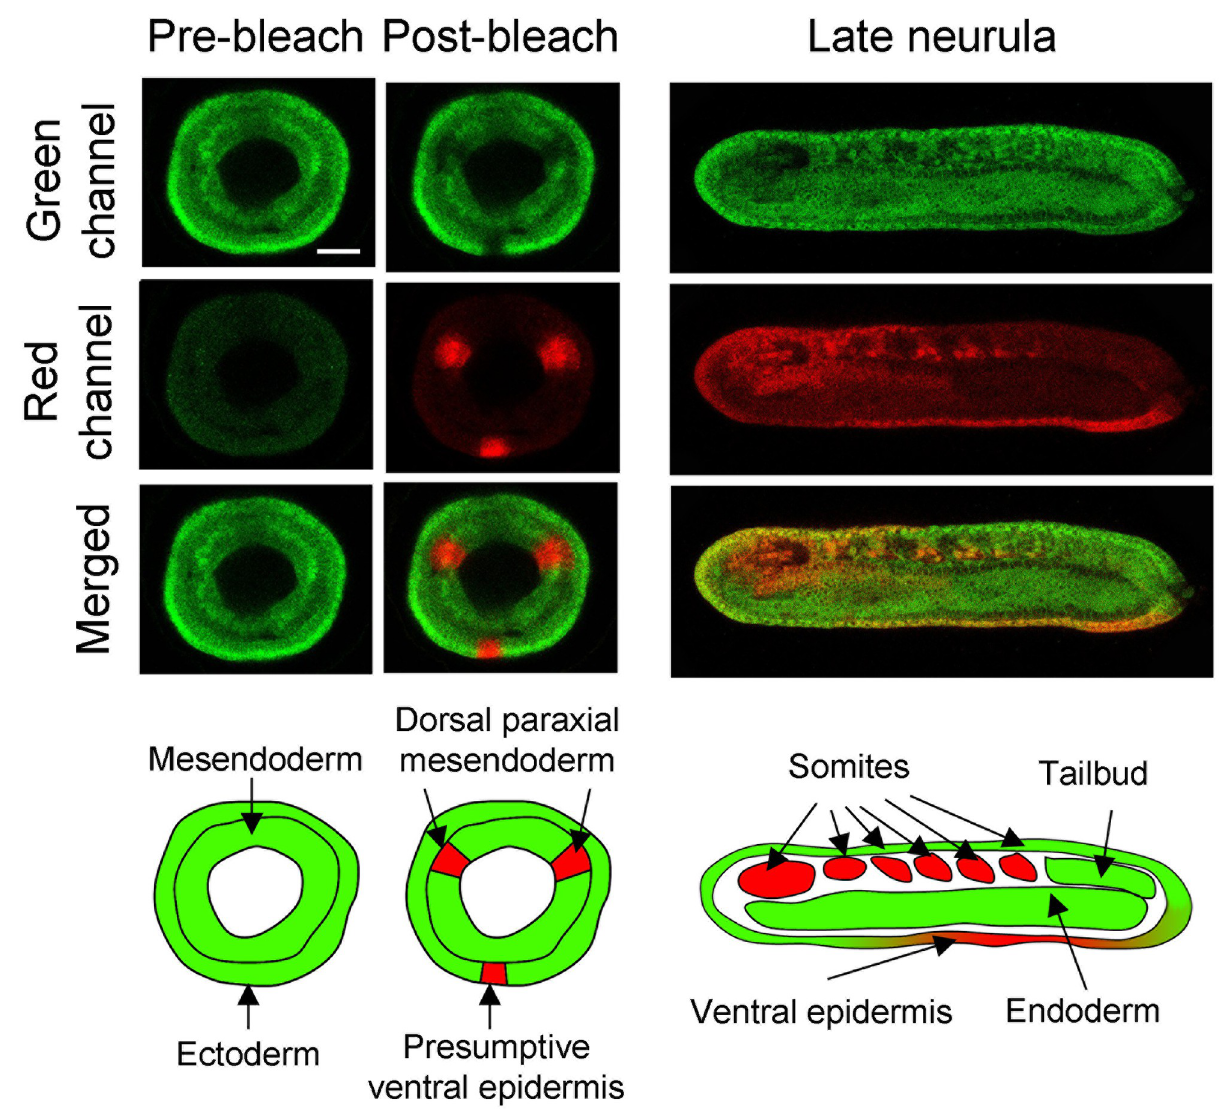
Fig 2. Example of expected results for a cell tracking experiment using Kaede photoconversion in the amphioxus embryo. The gastrula stage embryo (G4 stage) [13, 14] was imaged before and after photoconversion (pre- and post-bleach, panels on the left). The same embryo was imaged at the late neurula stage (N4 stage) [13, 14] (panels on the right). Gastrula stage pictures are blastopore views with dorsal to the top. Neurula stage images are side views with anterior to the left and dorsal to the top. Scale bar: 25 μ m.